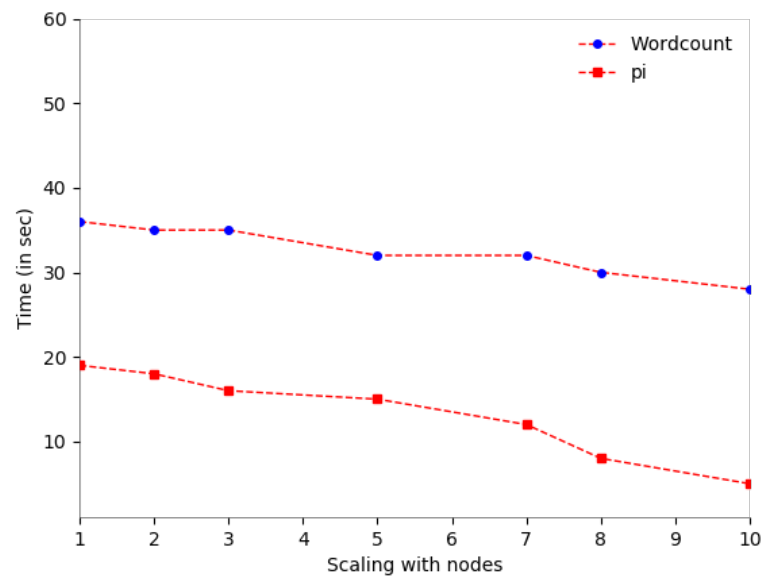
Figure 3. HPDA performance